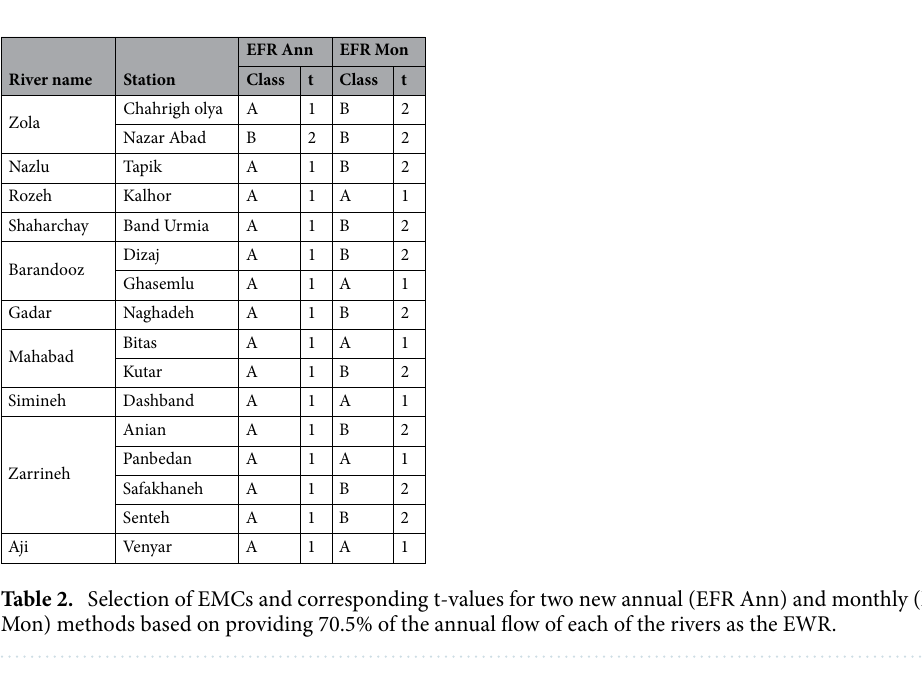
According to the results ofTable 2, the annual method, the major EMC that is selected to supply 70.5% of AF volume is class A. While in the monthly method, the major selected EMC for supply this amount of water is class B.